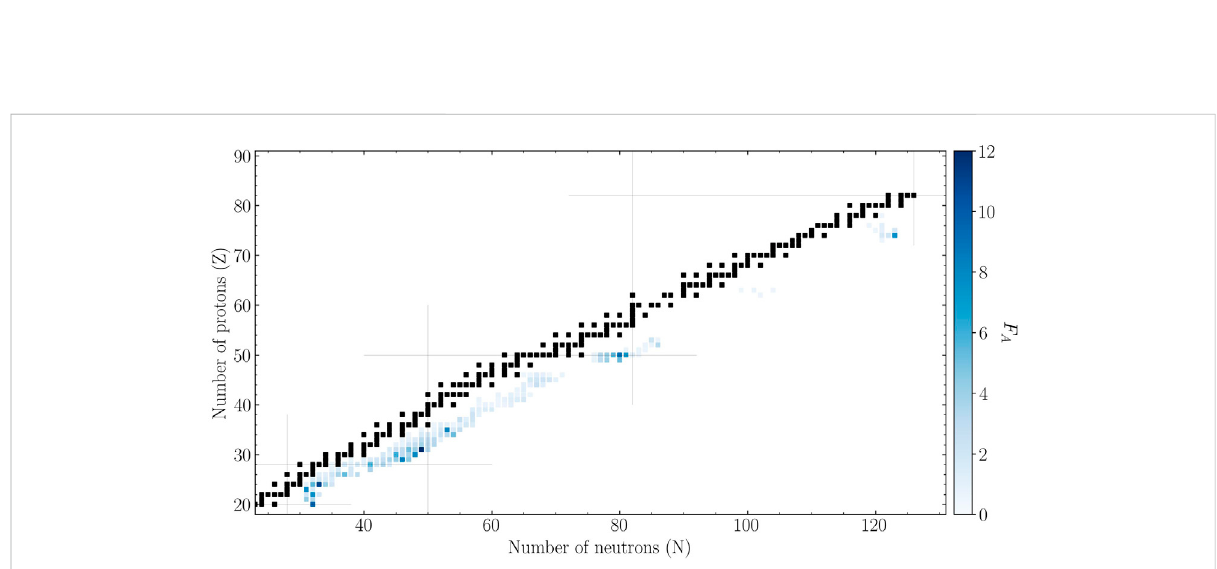
FIGURE 5 Combined results of all neutron-capture rate sensitivity studies performed. The shading represents the sensitivity measure F A . Only nuclei with sensitivity values F A greater than 0.5 in at least one of considered astrophysical trajectories are shaded. Black squares denote stable nuclei.